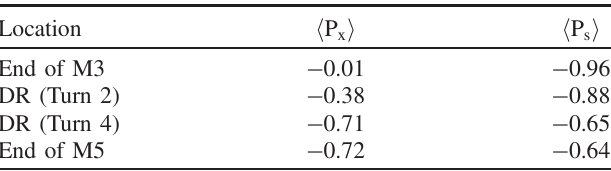
TABLE III. Average muon beam horizontal and longitudinal polarization at different Muon Campus locations.